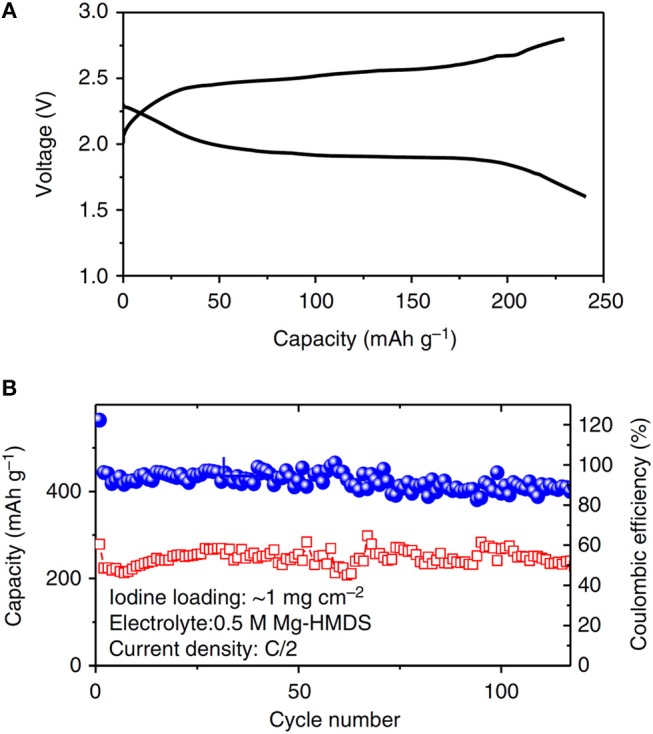
(A) Discharge/charge curve. (B) Cycling stability of the Mg-I2 batteries with bis-amide electrolytes. Reprinted with permission of Nature communications © 2017 Springer nature Ltd.